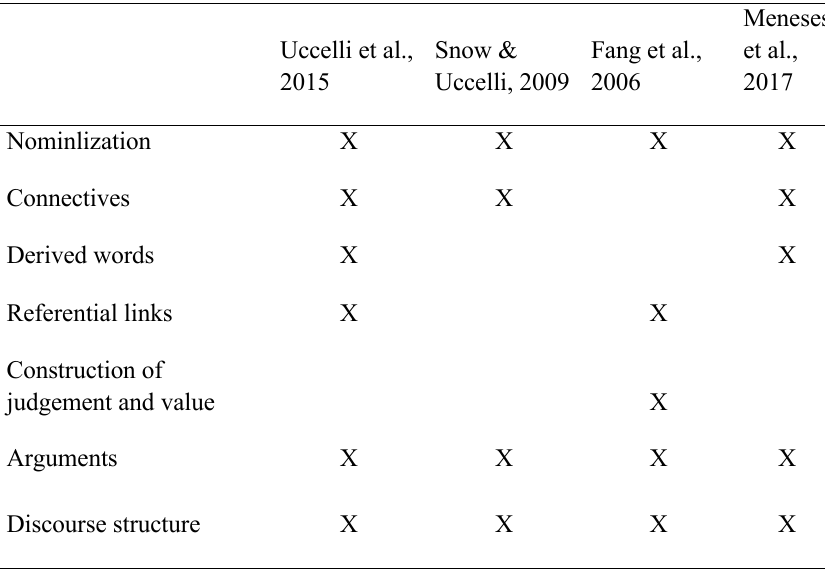
Table 1. Academic language skills identified in the